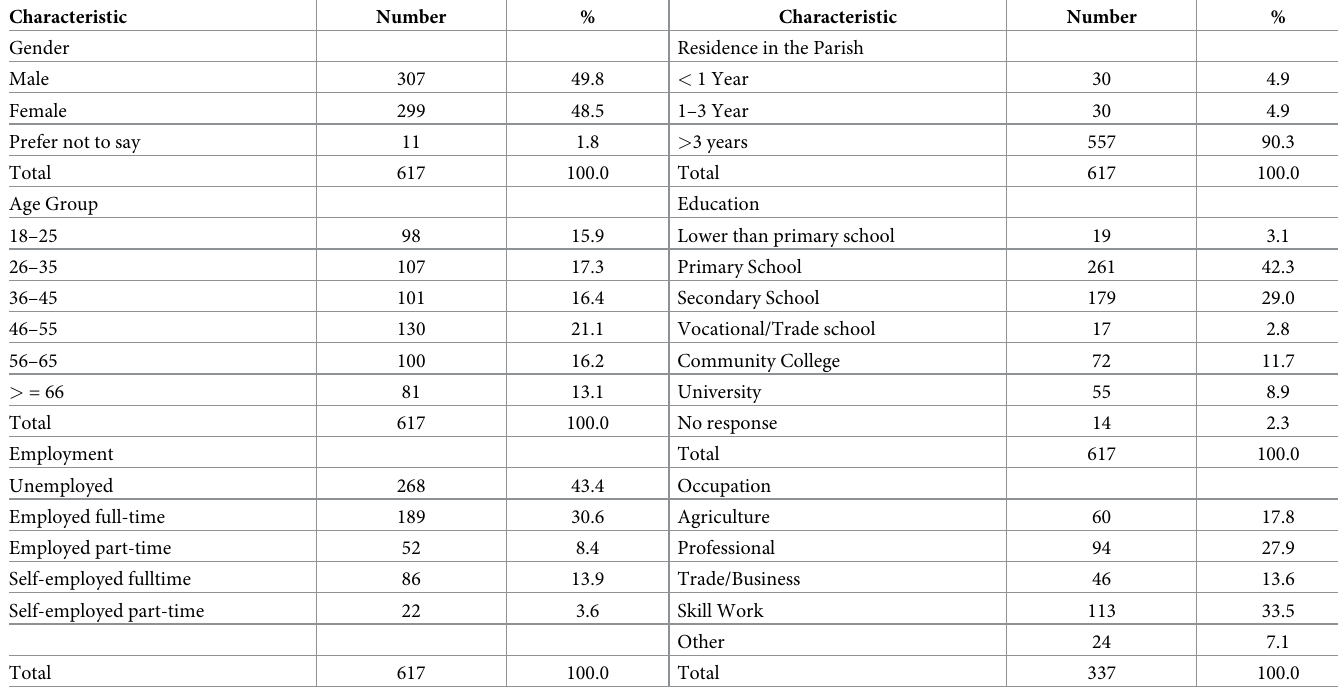
Table 1. Demographic characteristics of respondents.